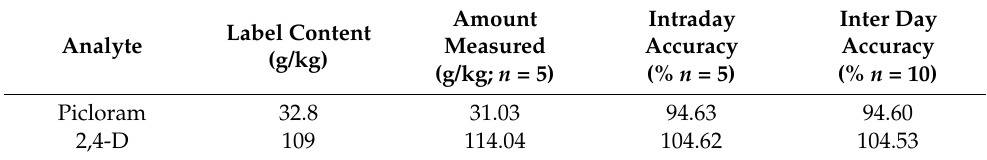
Table 3. Accuracy for picloram and